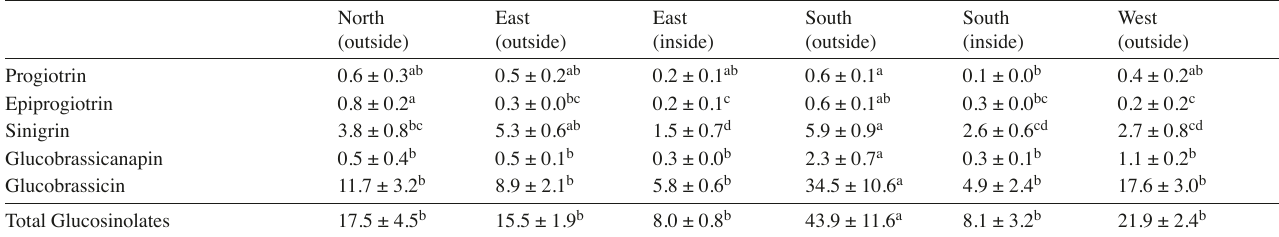
Tab. 5: Concentration of glucosinolates progoitrin, epiprogiotrin, sinigrin, glucobrassicanapin, glucobrassicin, and total glucosinolates [mg * 100 g -1 FW] in kale samples harvested after 7 weeks of growth under urban gardening conditions in northern, southern, western, and eastern locations, including 2 indoor locations (east and south). Different letters indicate significant differences of means according to Tukey’s test ( p ≤ 0.05).